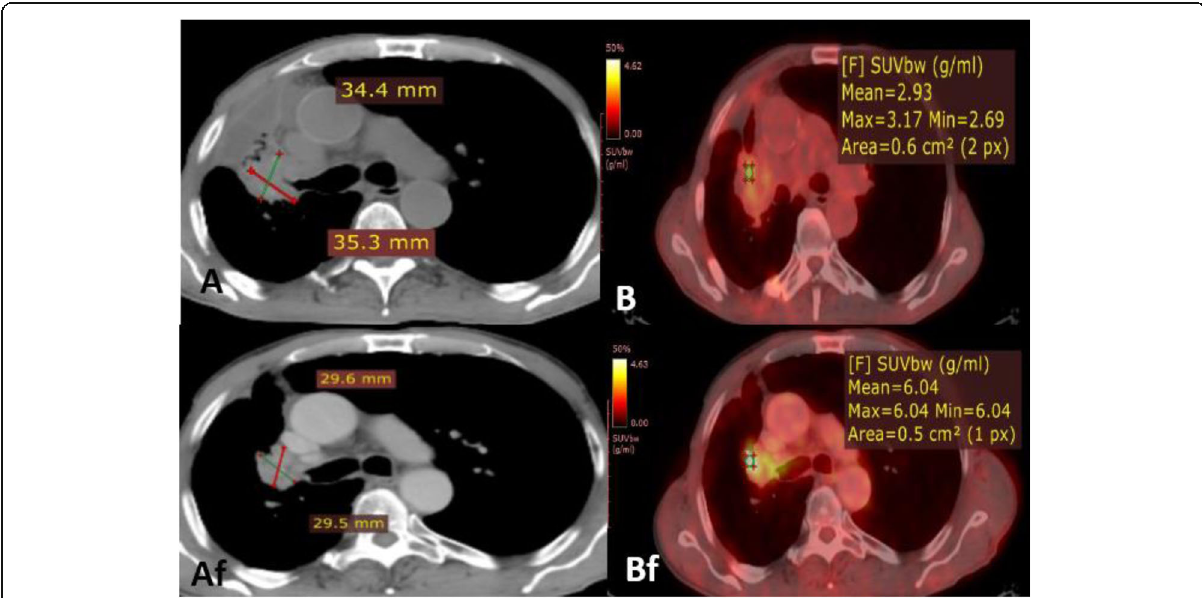
Fig. 12 A male patient 45 years old diagnosed to have NSCLC received chemotherapy. Baseline study ( A and B ) showed the mass lesion = 35.3 × 34.4 mm on average with SUV uptake = 2.9. On follow-up after 3 months ( Af and Bf ) showed decrease in the size of the mass by CT = 29.6 × 29.5 mm in average interpreted as stable disease by RECIST criteria (the decrease in size not met the criteria of partial response by RECIST criteria) while in PET/CT, the SUV increased to be 6.04 instead of 2.9 leading to change in opinion to be progressive disease response by PERCIST criteria instead of stable disease by RECIST criteria